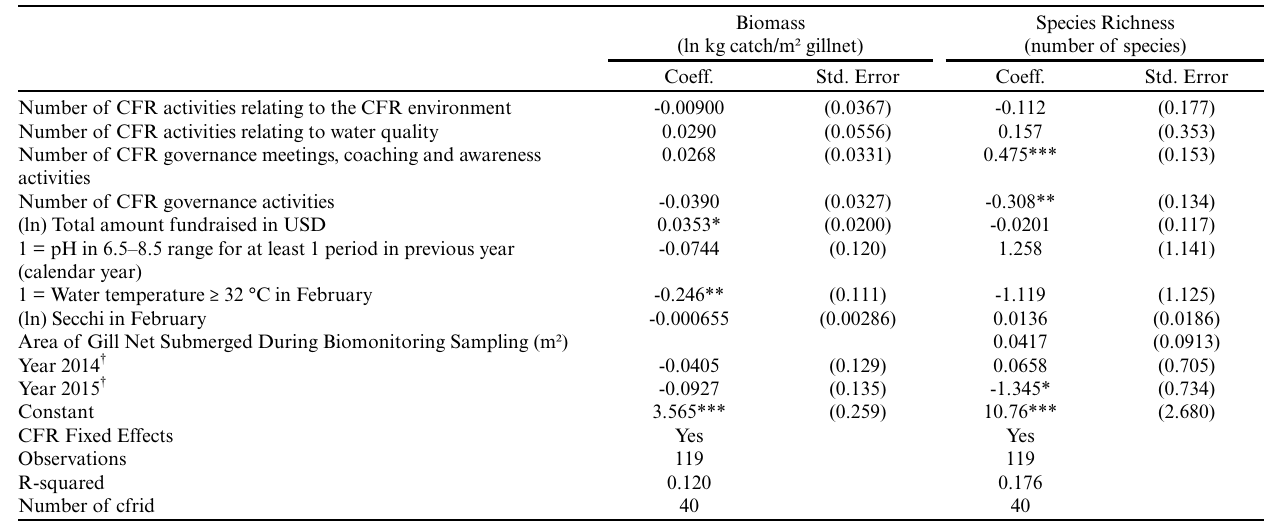
Table 4 . Relationships between governance actions and community fish refuge (CFR) biomass and biodiversity. Using longitudinal regression models that include fixed effects for the CFR, we show relationships between the number of governance activities, governance meetings, and the quantity of funds raised in the previous year (“lagged” values below) and the current biomass and species richness in CFRs. Our models also control for the CFR activities related to the environment and water quality, as well as water quality and year. “ln” refers to the natural